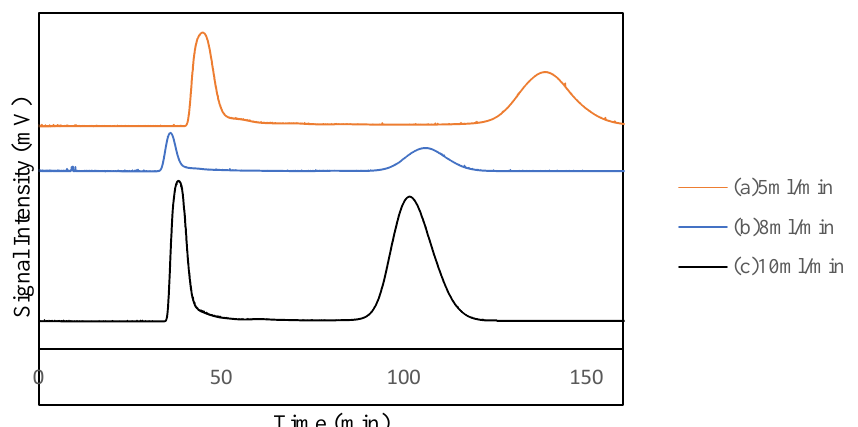
Figure 4. HSCCC chart of mulberry leaf crude extracts with different flow phase velocities of ( a ) 5 mL/min, ( b ) 8 mL/min, and ( c ) 10 mL/min. Table 3. Effect of mobile phase flow rate on the separation effect.